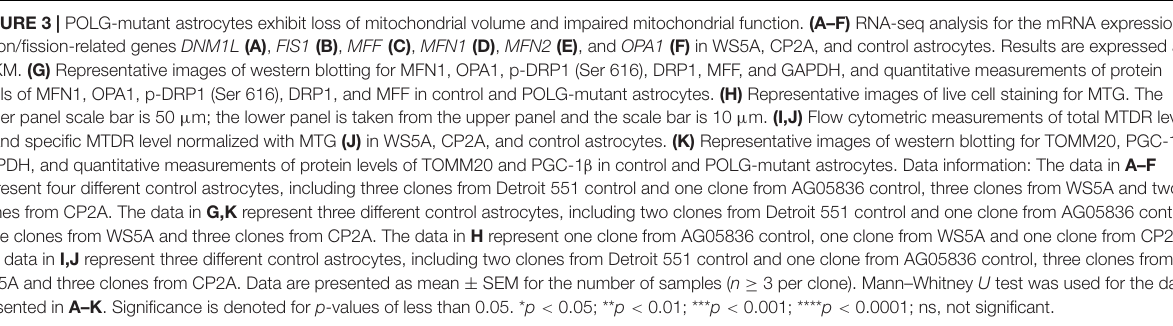
FIGURE 3 | POLG-mutant astrocytes exhibit loss of mitochondrial volume and impaired mitochondrial function. (A–F) RNA-seq analysis for the mRNA expression of fusion/fission-related genes DNM1L (A) , FIS1 (B) , MFF (C) , MFN1 (D) , MFN2 (E) , and OPA1 (F) in WS5A, CP2A, and control astrocytes. Results are expressed as FPKM. (G) Representative images of western blotting for MFN1, OPA1, p-DRP1 (Ser 616), DRP1, MFF, and GAPDH, and quantitative measurements of protein levels of MFN1, OPA1, p-DRP1 (Ser 616), DRP1, and MFF in control and POLG-mutant astrocytes. (H) Representative images of live cell staining for MTG. The upper panel scale bar is 50 µ m; the lower panel is taken from the upper panel and the scale bar is 10 µ m. (I,J) Flow cytometric measurements of total MTDR level (I) and specific MTDR level normalized with MTG (J) in WS5A, CP2A, and control astrocytes. (K) Representative images of western blotting for TOMM20, PGC-1 β , GAPDH, and quantitative measurements of protein levels of TOMM20 and PGC-1 β in control and POLG-mutant astrocytes. Data information: The data in A–F represent four different control astrocytes, including three clones from Detroit 551 control and one clone from AG05836 control, three clones from WS5A and two clones from CP2A. The data in G,K represent three different control astrocytes, including two clones from Detroit 551 control and one clone from AG05836 control, three clones from WS5A and three clones from CP2A. The data in H represent one clone from AG05836 control, one clone from WS5A and one clone from CP2A. The data in I,J represent three different control astrocytes, including two clones from Detroit 551 control and one clone from AG05836 control, three clones from WS5A and three clones from CP2A. Data are presented as mean ± SEM for the number of samples ( n ≥ 3 per clone). Mann–Whitney U test was used for the data presented in A–K . Significance is denoted for p -values of less than 0.05. * p < 0.05; ** p < 0.01; *** p < 0.001; **** p < 0.0001; ns, not